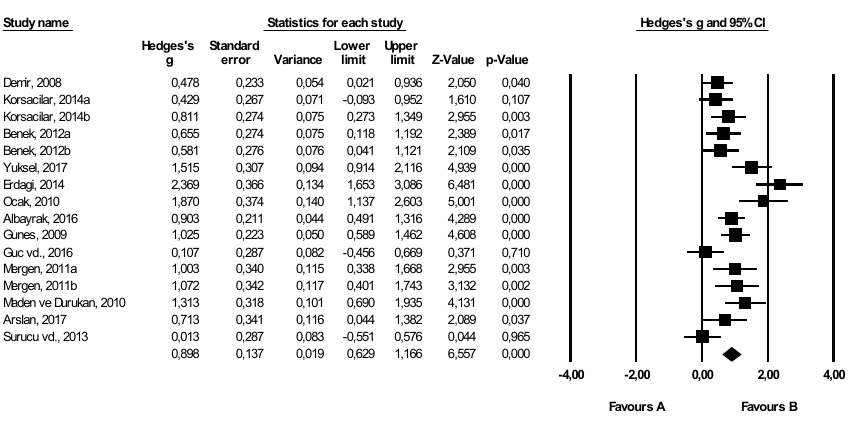
Figure 3. Meta-Analysis